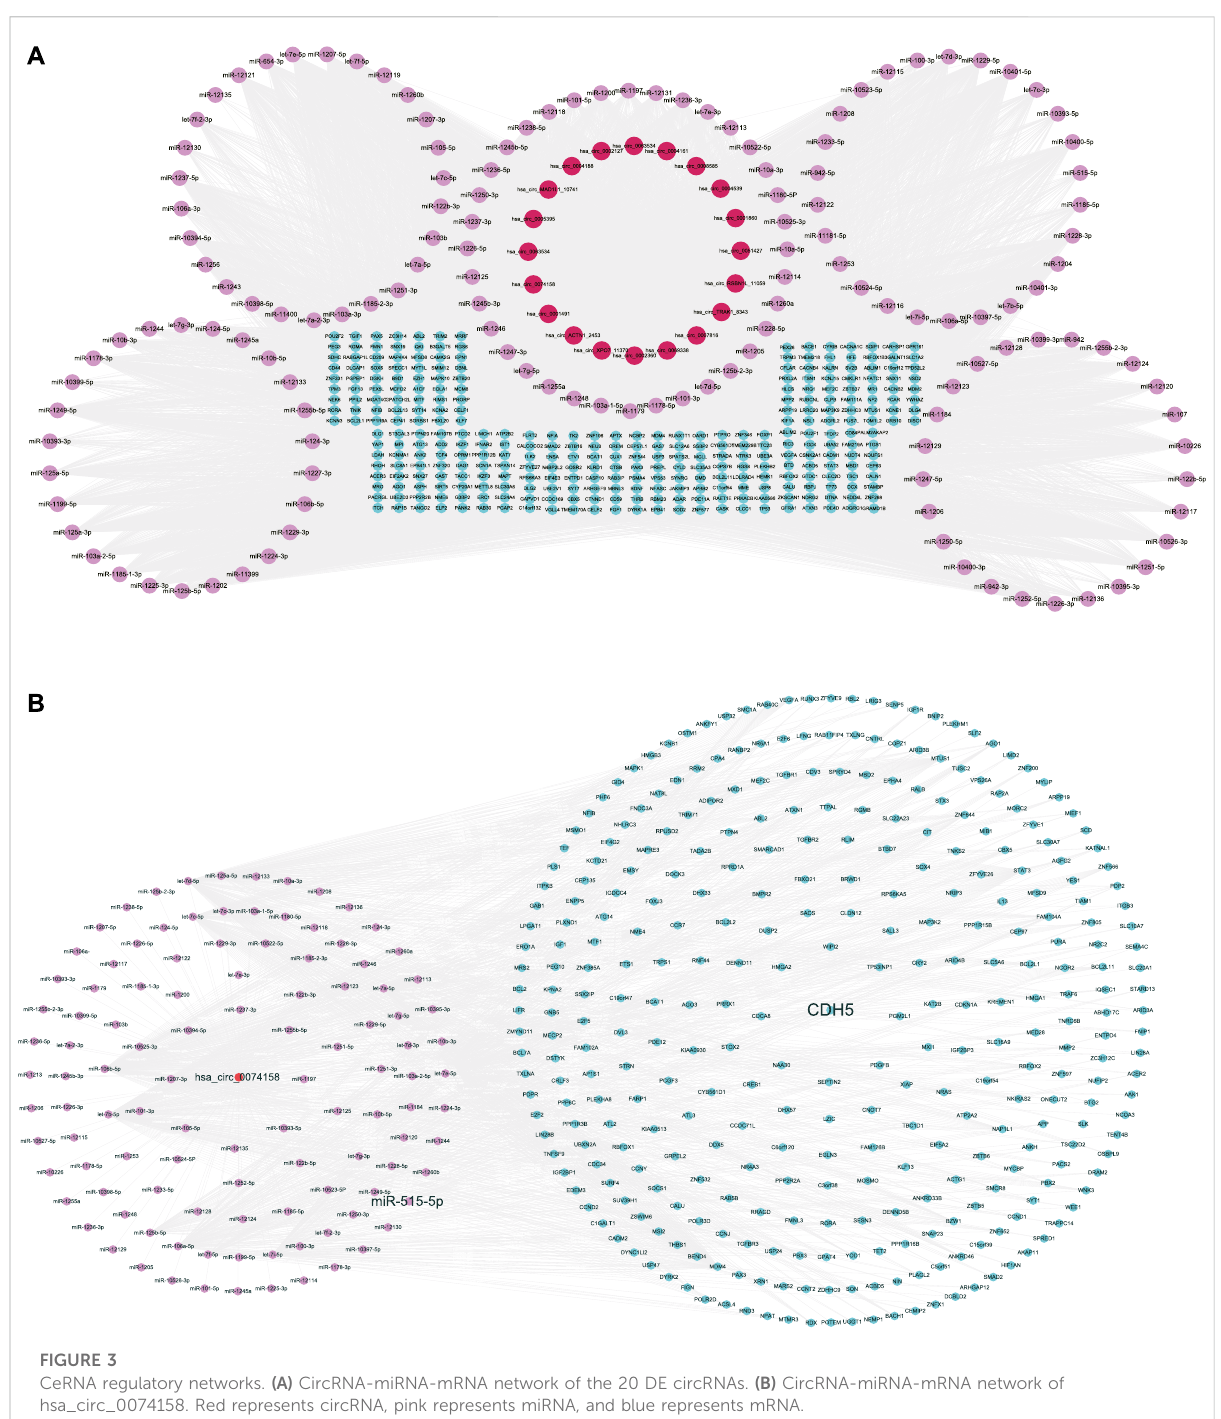
FIGURE 3 CeRNA regulatory networks. (A) CircRNA-miRNA-mRNA network of the 20 DE circRNAs. (B) CircRNA-miRNA-mRNA network of hsa_circ_0074158. Red represents circRNA, pink represents miRNA, and blue represents